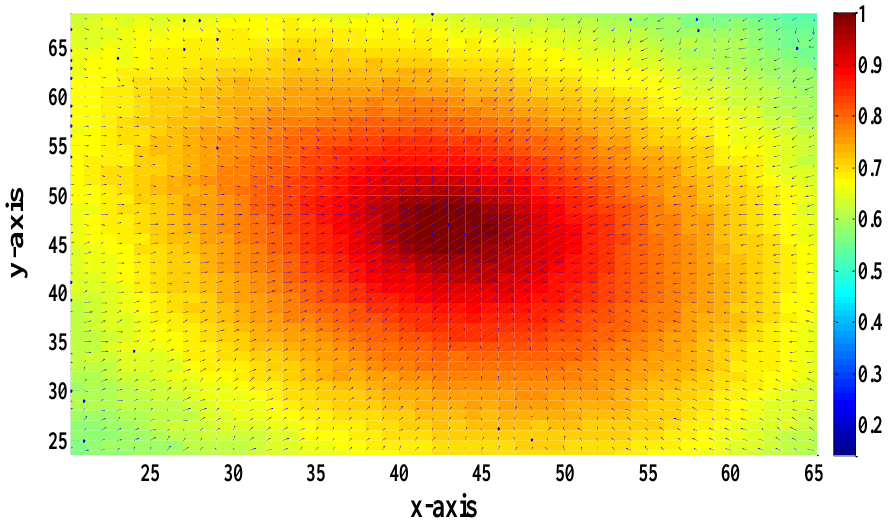
Fig.8: The same as in Fig. 7 but superimposed on the raw data of the